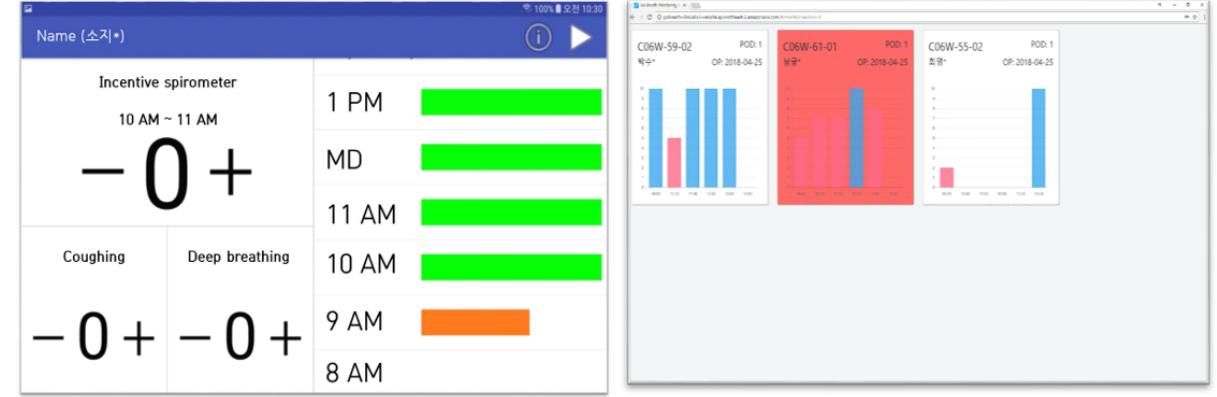
Figure 2. Screenshot of the Go-breath app (left) and dashboard (right). The original version was in Korean, but it was modified to display